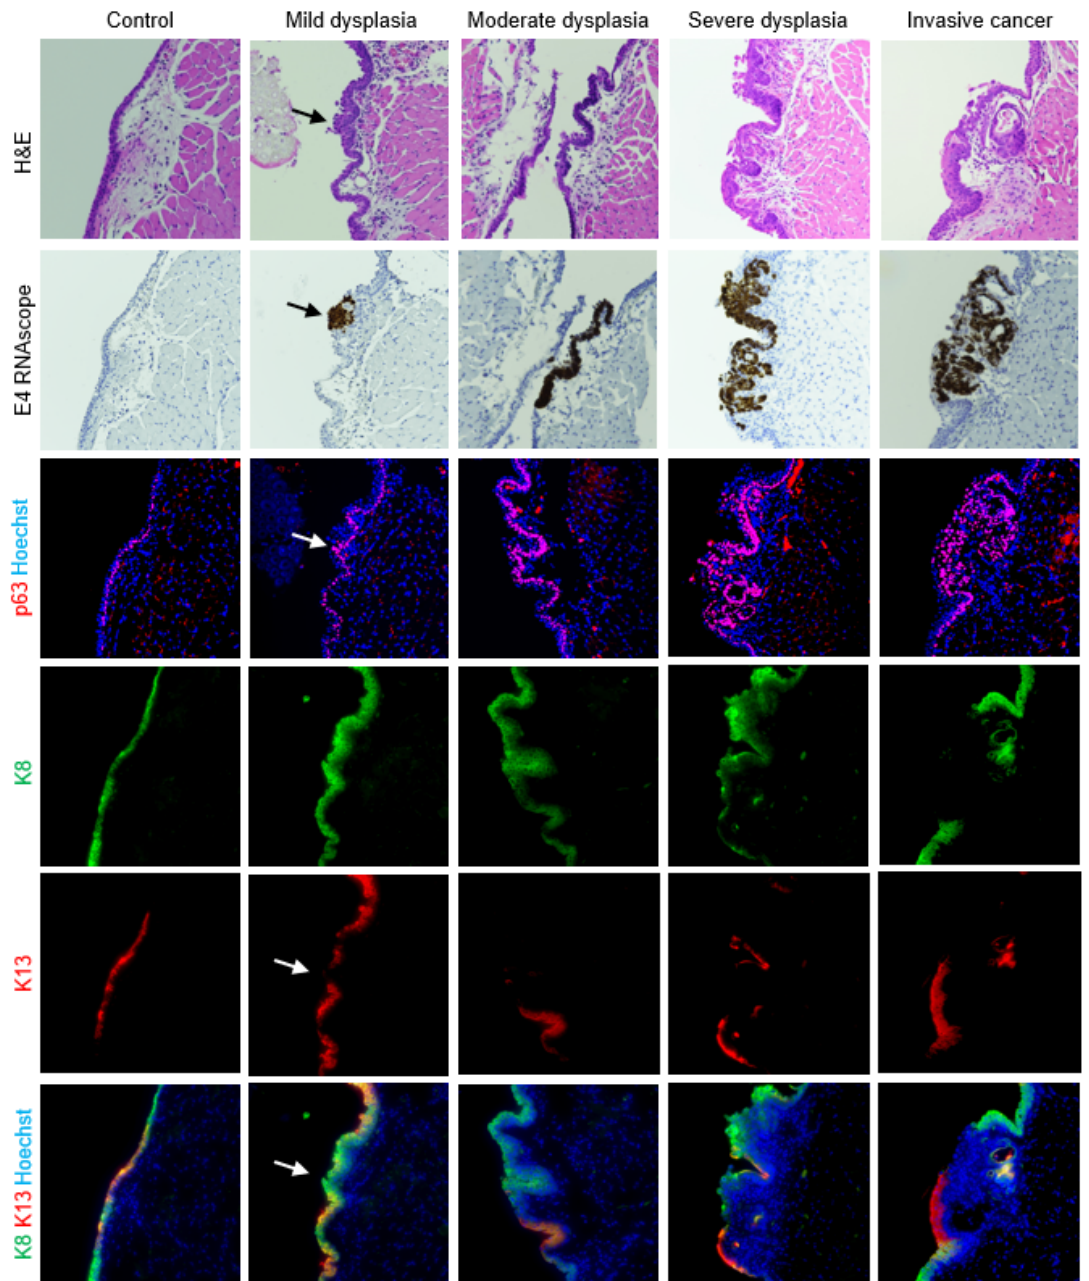
Figure 4. Expanded epithelial basal compartment in MmuPV1-induced vocal fold disease. Serial sections of control and diseased vocal folds stained with H&E, MmuPV1 E4 RNAscope ISH, cos- tained p63 (red) and Hoechst (blue) IF, and costained K8 (green), K13 (red), and Hoechst (blue) IF shown both as separate channels and merged. 40× magnification. Arrows: MmuPV1-positive focal dysplasia with suprabasal p63 and reduced K13. Some H&E and RNAscope images reproduced with permission from our companion paper [3].